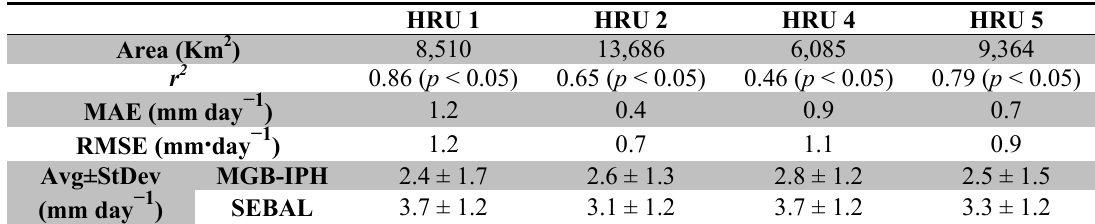
Table 1. Comparisons between daily evapotranspiration estimated by SEBAL and MGB-IPH. Labels: HRU 1 (pasture, grassland and cropland areas with soils of medium storage capacity); HRU 2 (cropland areas with soils of high storage capacity); HRU 4 (forest and reforested areas on soils with medium storage capacity); HRU 5 (pasture, grassland and bare soil on soils with high storage